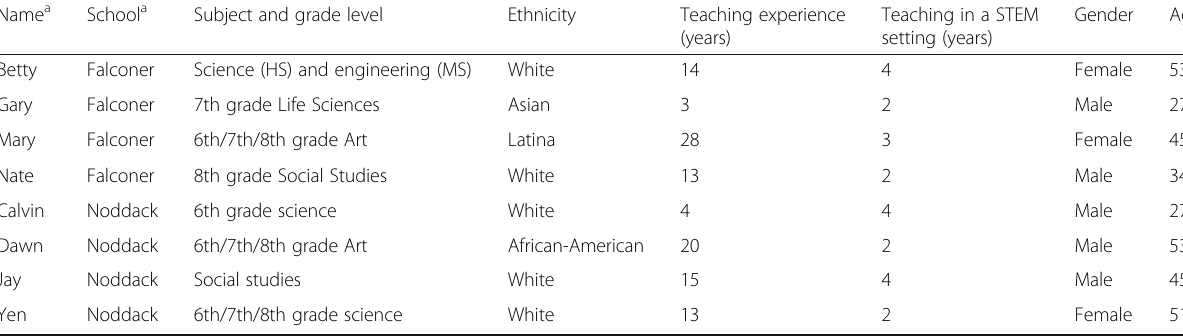
Table 1 Teachers ’ demographics and experience in both STEM and non-STEM settings